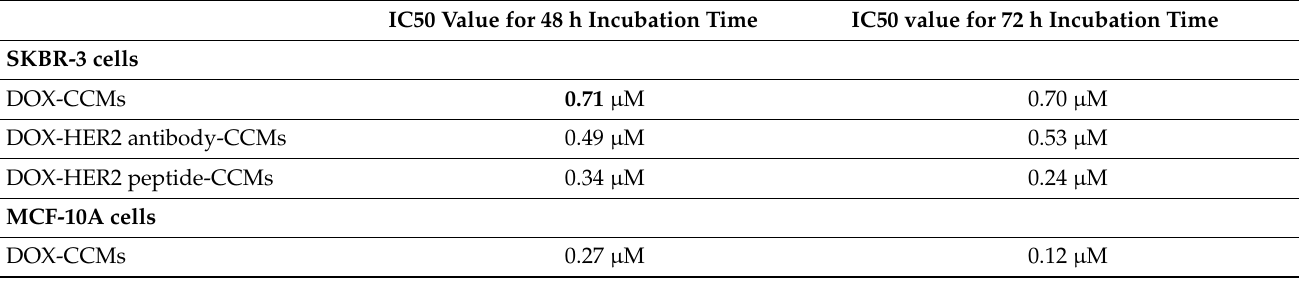
Table 2. Summary of the IC50 values of DOX-CCMs, DOX-HER2 peptide-CCMs, and DOX-HER2 antibody-CCMs on SKBR-3 and MCF-10A for 48 and 72 h incubation